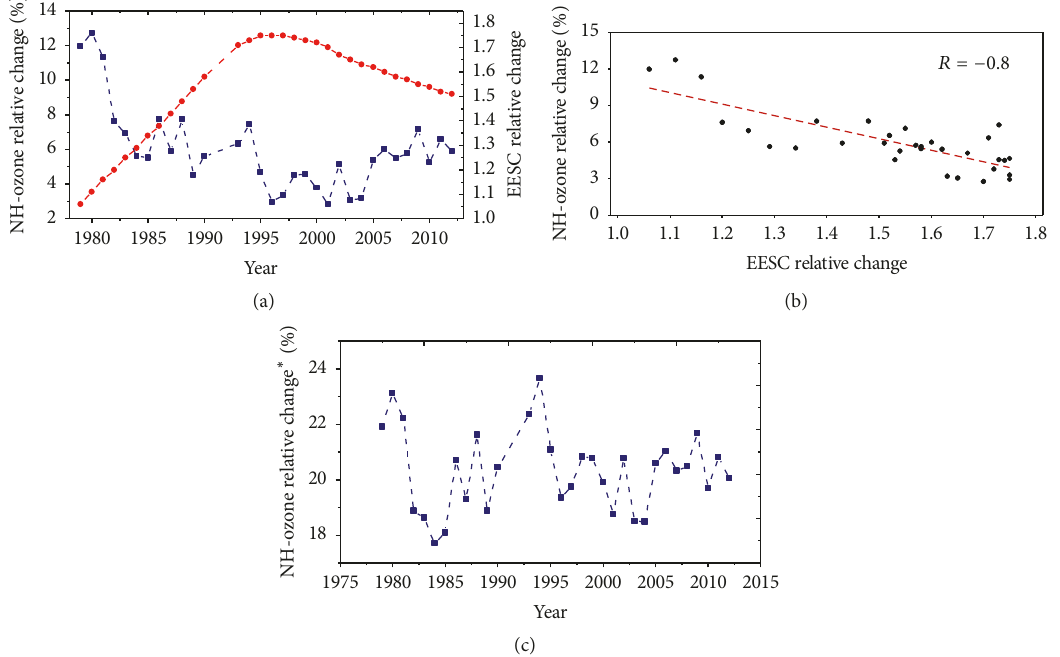
Figure 4: (a) The northern polar ozone relative anomalies (blue squares connected with dash lines) and the EESC data (red spots connected with dash lines); (b) the correlation between the northern polar ozone relative anomalies and the EESC data, the red dash line is the linear fitting of the points; (c) the northern polar ozone relative anomalies after detrending the EESC effects (blue squares connected with dash lines). NH- 𝑂 ∗ var denotes that the ozone data of NH has detrended the EESC